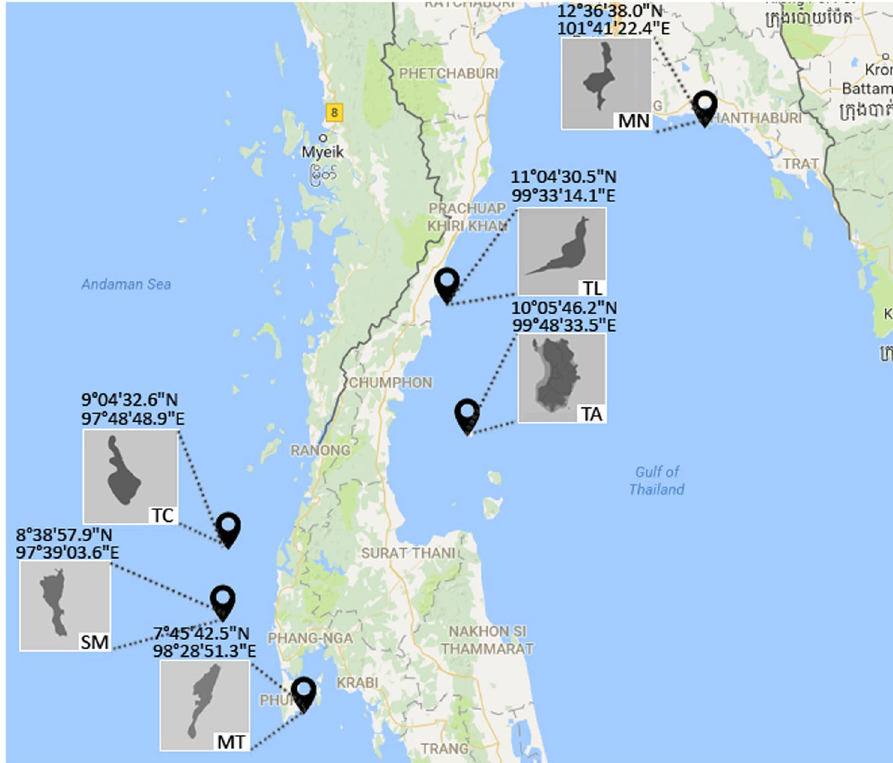
Figure 1. A map showing the sampling sites (with GPS coordinates) in the Gulf of Thailand and Andaman Sea. Sampling locations are abbreviated as follows: Mannai (MN), Talu (TL), Tao (TA), Tachai (TC), Similan (SM) and Maiton (MT). The main and inset maps were drawn using the R packages 83 ‘ggplot2’ version 2.2.1 (https:// cran.r-project.org/web/packages/ggplot2/ggplot2.pdf) 84 and ‘ggmap’ version 2.6.1 (https://cran.r-project.org/ web/packages/ggmap/ggmap.pdf) 85 . The static map of the Gulf of Thailand and Andaman Sea displayed was queried from the Google Maps (Map data © 2016 Google) using the function ‘get_map’ in the ‘ggmap’ package.